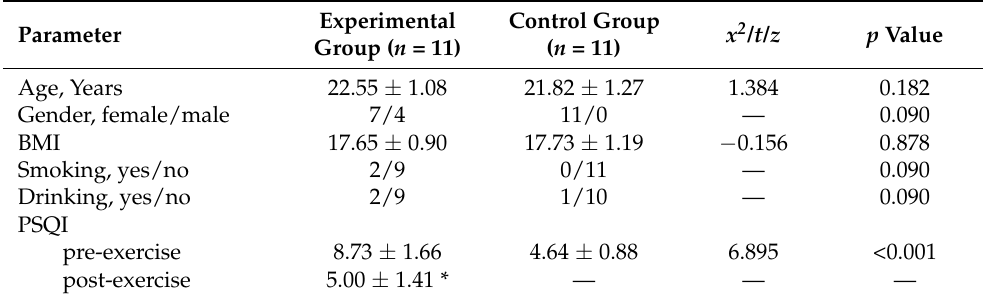
Table 1. Demographic characteristics of the experimental group and the control group.